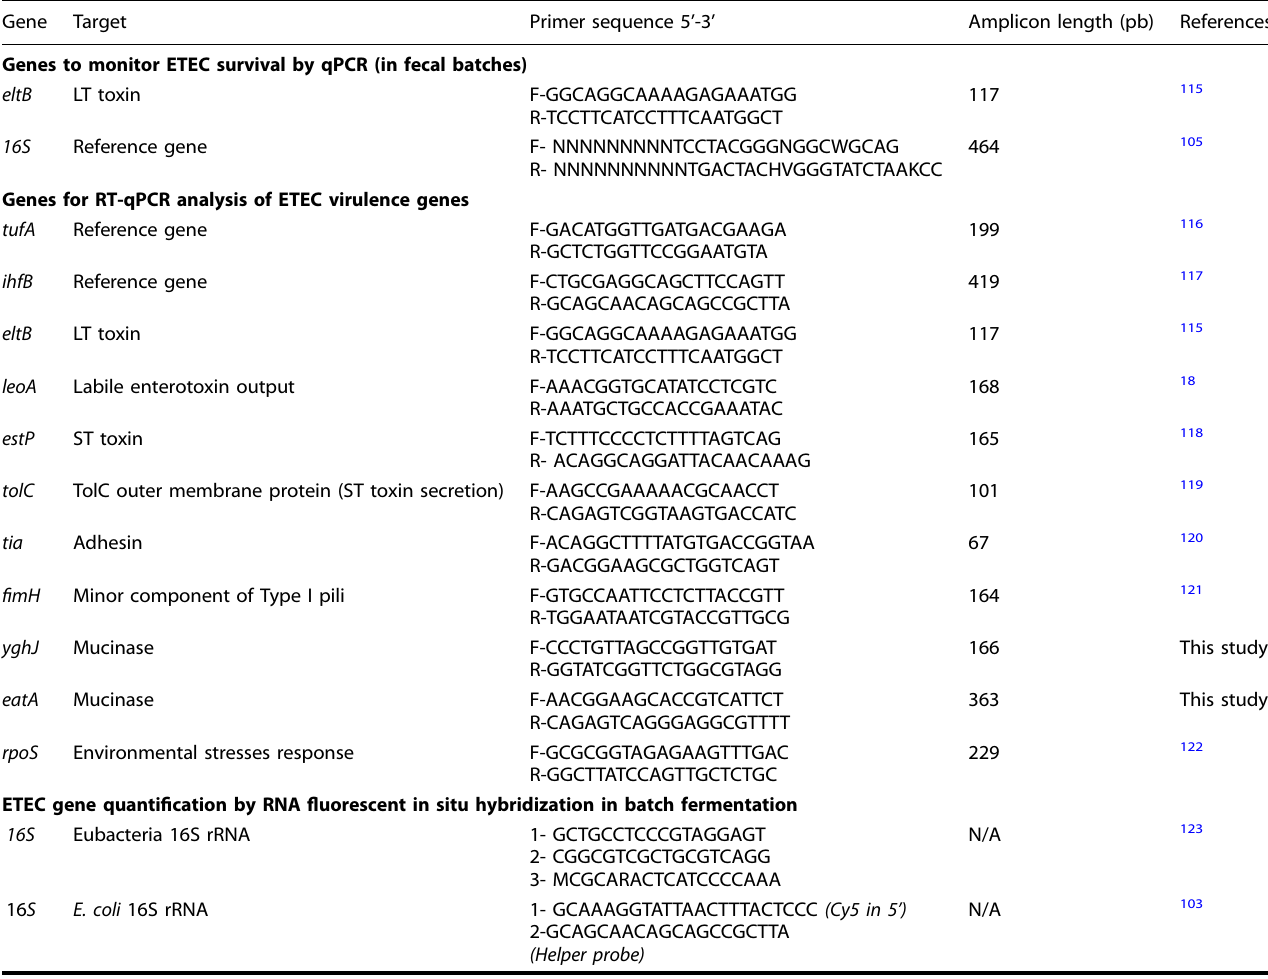
Table 3. ETEC primers used in the